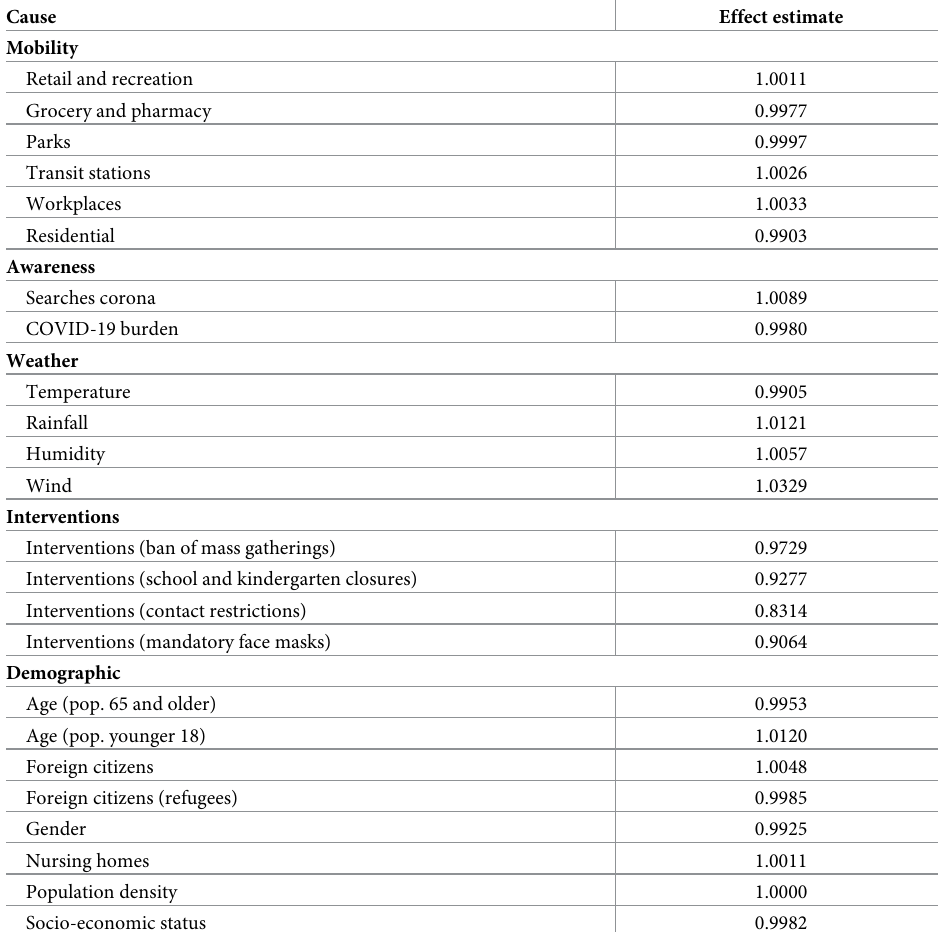
Table 3. Effect estimates from causal graph